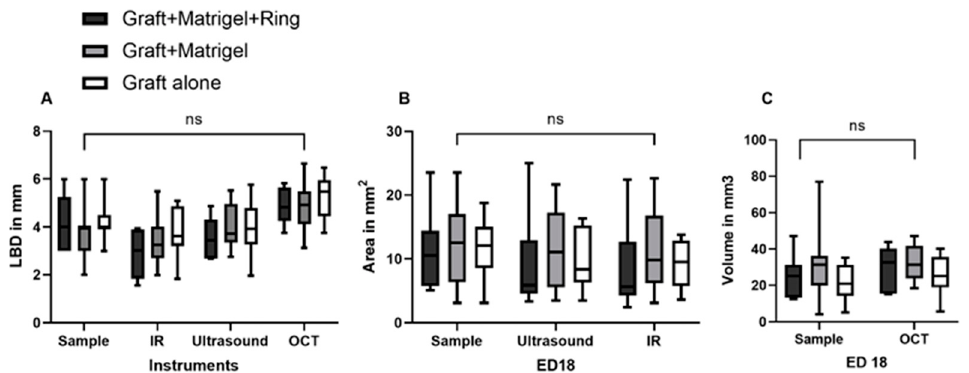
Figure 9. Comparison of the largest basal diameter, the area, and the volume of the implanted uveal melanoma patient-derived grafts, measured with various tested monitoring instruments. ( A ) The largest basal diameter (LBD) of the tumor grafts in all three tested groups of implantation (group 1: graft + Matrigel + ring, group 2: graft + Matrigel, and group 3: graft alone) as calculated on ED18 for the excised samples with infrared imaging (IR), ultrasound, and optical coherence tomography (OCT). ( B ) The cross-sectional area of the tumors was measured by ultrasound and IR. ( C ) The volume calculated with the size parameters of the excised samples, as well as with the OCT measurements, regarding depth invasion. Statistical analysis was performed using a two-way ANOVA and Tukey’s multiple comparisons test. ns = non significant.